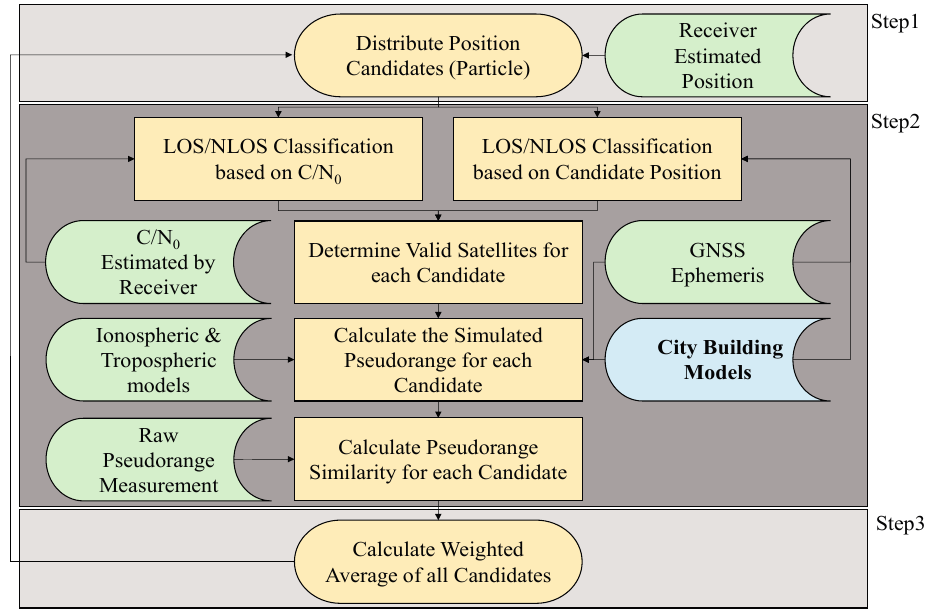
Figure 2. Flowchart of the developed 3D building model based positioning